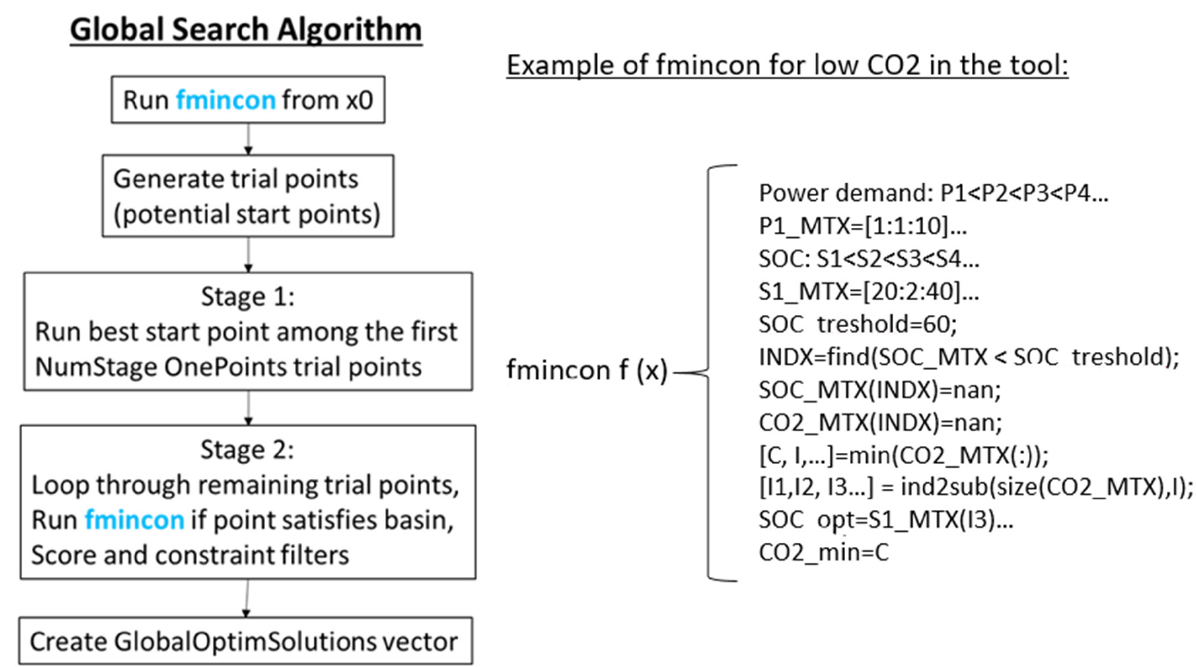
Figure A1. Algorithm of GS optimization [20] and example of fmincon for minimizing CO 2 emissions in the